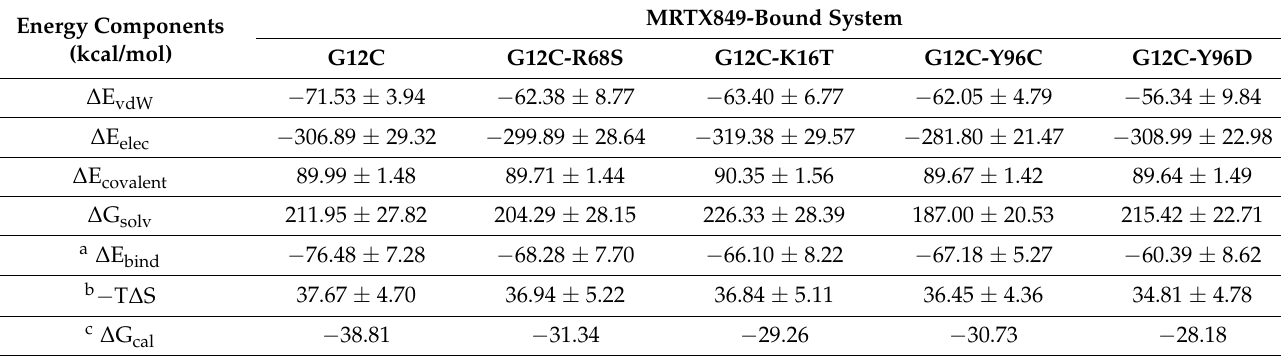
Table 2. Binding affinities of the MRTX849 mutant complexes from calculation and experiment.